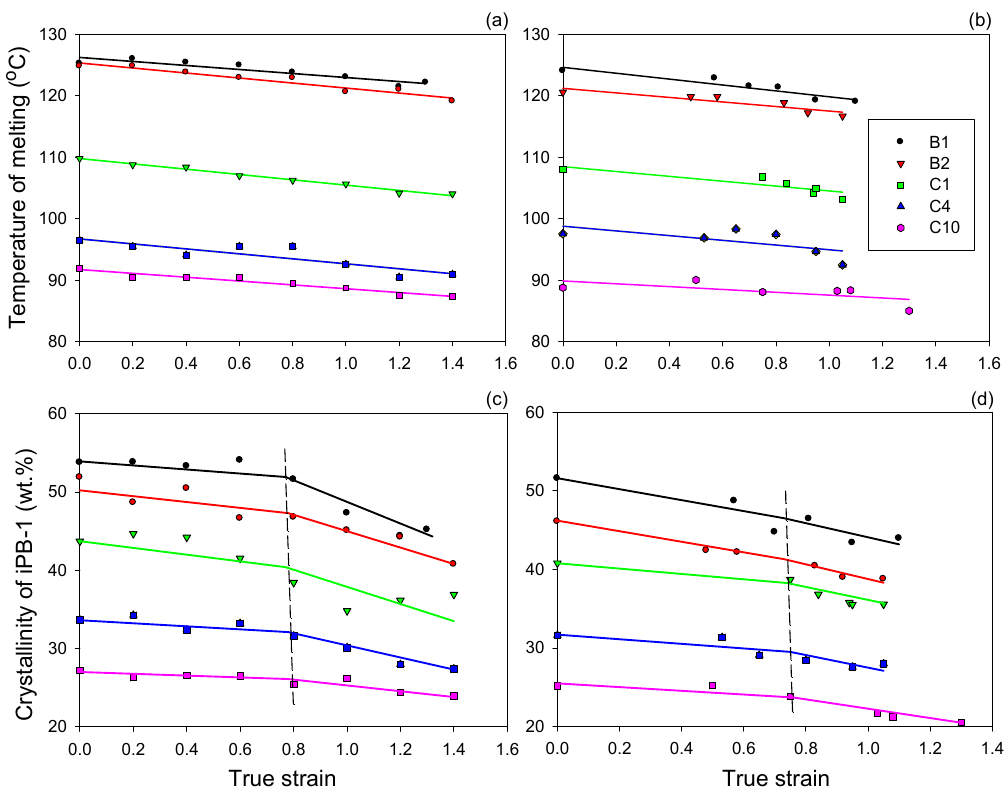
Figure 4. The dependencies of the melting temperature ( a , b ) and iPB-1 crystallinity evaluated from the area of the main melting peak ( c , d ) on true strain applied in compression ( a , c ) and tension ( b , d ). The crystallinity was calculated with respect to the weight fraction of the iPB-1 species in the sample. Symbols of samples are indicated in ( b ). Straight line segments were drawn to guide the eye only, and they do not represent any real dependence.